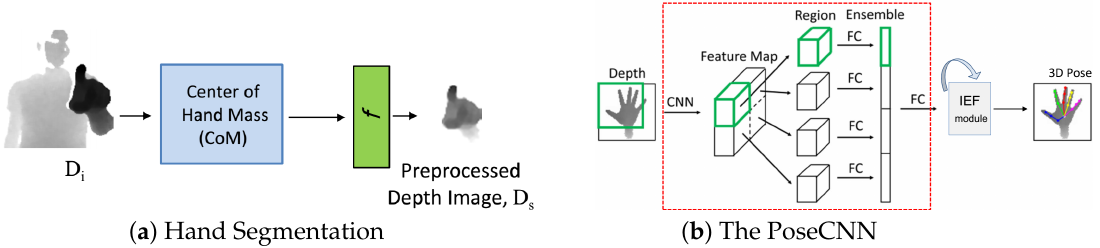
Figure 3. ( a ) shows our approach for hand segmentation from a raw depth frame. First, the center of hand mass (CoM) is calculated, provided that the hand is the closest object to the depth camera. Then, the function f crops the hand region in 3D. ( b ) The PoseCNN takes the cropped hand image as input and regresses 3D sparse joints